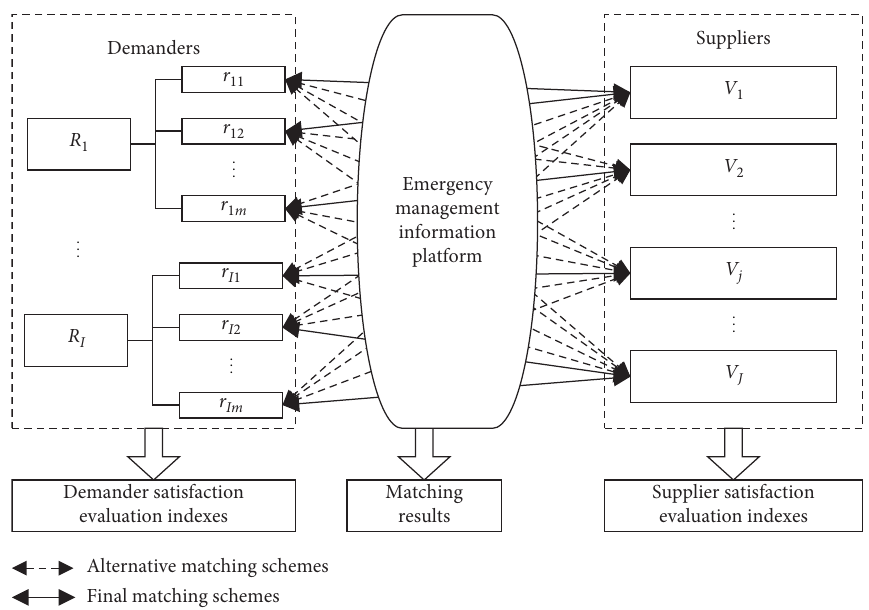
Figure 1: Two-sided matching mode of emergency platform.